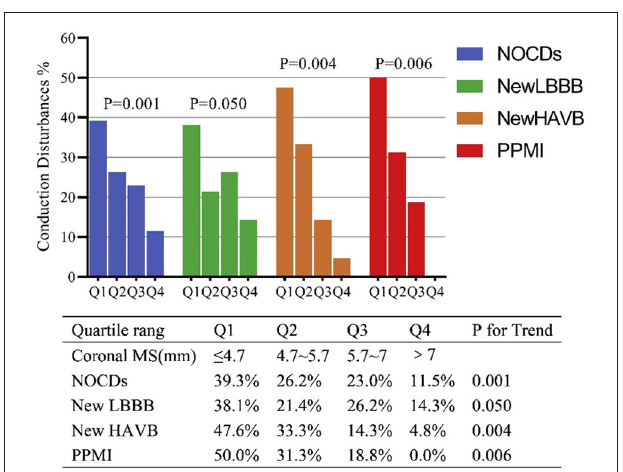
FIGURE 3 | Incidence of NOCDs according to quartiles of coronal MS. MS, membranous septum; LBBB, left bundle branch block; HAVB, high-grade.